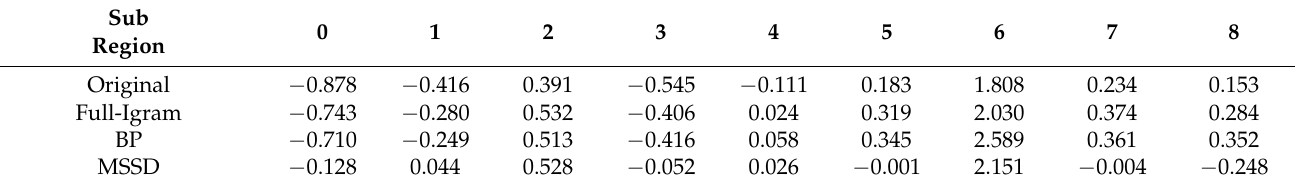
Figure 8. Scatter plots (phase difference vs. topographic height difference, blue dots) in various Figure 8. Sca tt er plots (phase di ff erence vs. topographic height di ff erence, blue dots) in various spatial scales in the Sierra Nevada Mountains with an azimuth of 135 ◦ . This comparison shows the spatial scales in the Sierra Nevada Mountains with an azimuth of 135°. This comparison shows the influence of error on correlation coefficient R in different scales. in fl uence of error on correlation coe ffi cient R in di ff erent scales. Table 2. Correlation coefficients of 9